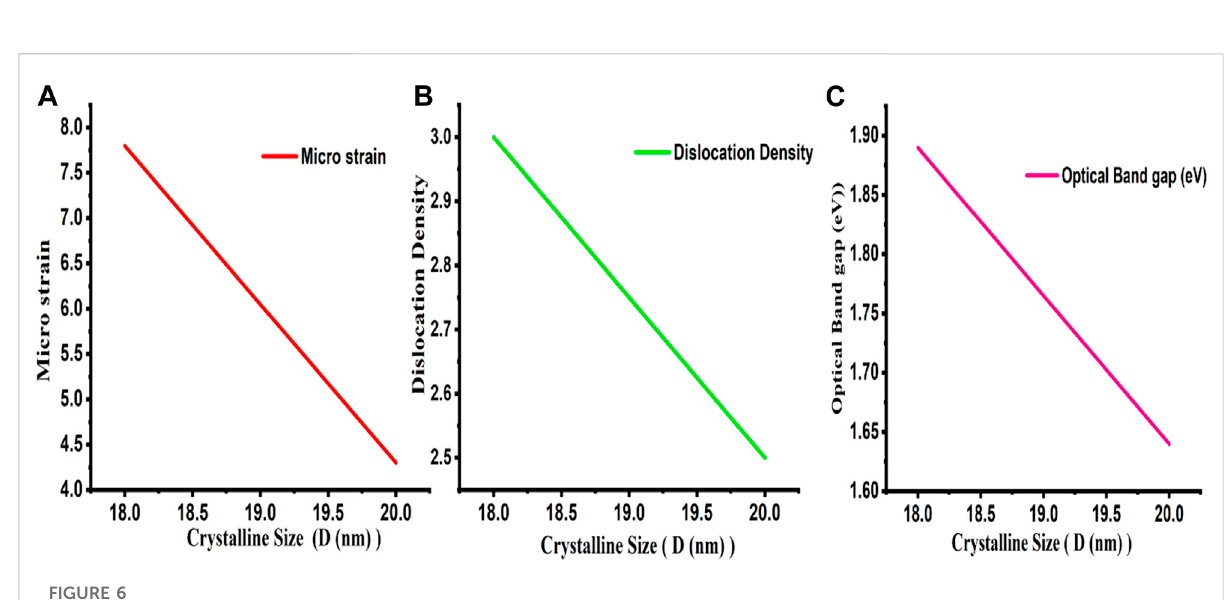
FIGURE 6 Variation of different parameters with crystalline size. (A) Micro strain (B) Dislocation Density (C) Optical Band